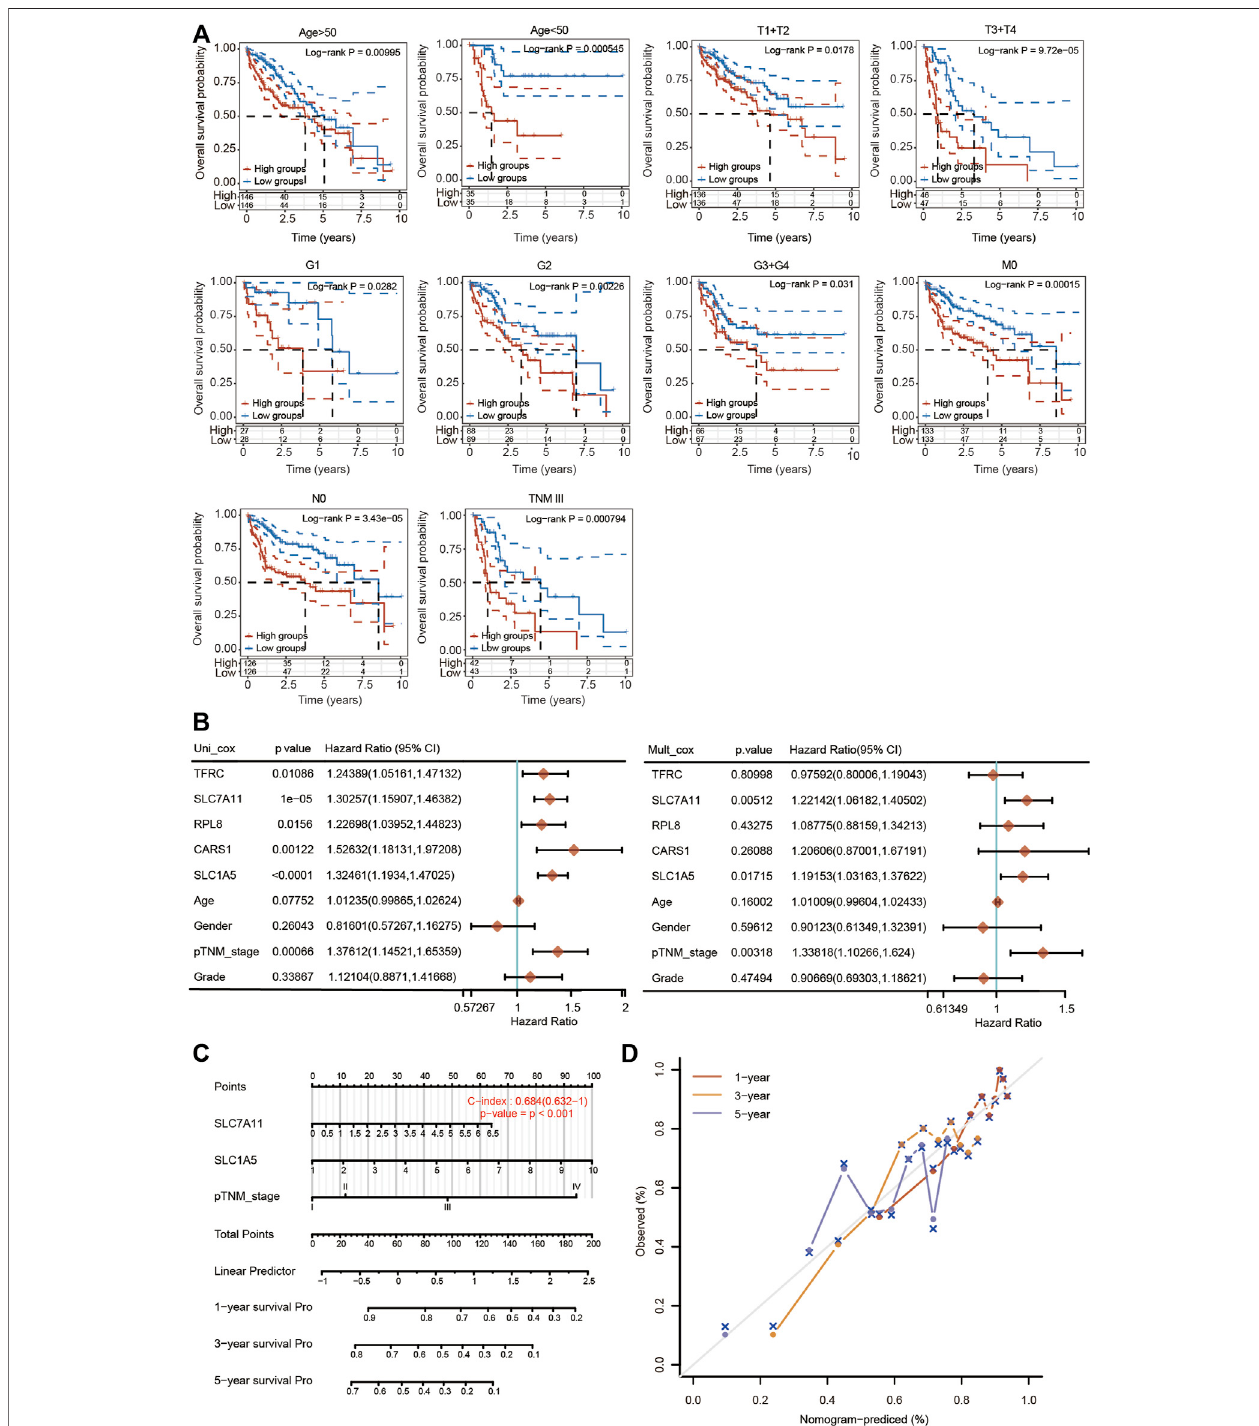
FIGURE9| Construction ofanomogram basedon fi veFRGs and clinicalfactors. (A) Kaplan – Meiercurves ofOSbetween everytwogroups strati fi edbyage < 50, age < 50,T1+T2,T3+T4,G1,G2,G3+G4,N0,M0andTNMstageIII( p < 0.05,Log-ranktest). (B) UnivariateandmultivariateCoxregressionanalysesof fi veFRGsand clinical factors are shown. (C) A stable and accurate hybrid nomogram that contains clinicopathological characteristics and the novel prognostic signature. Nomogram forpredicting1-,3-,and5-yearOS. (D) Calibration curvesweregeneratedandthe1-,3-,and5-yearpredictionsofthenomogramwereobservedtobeconsistent with the actual survival